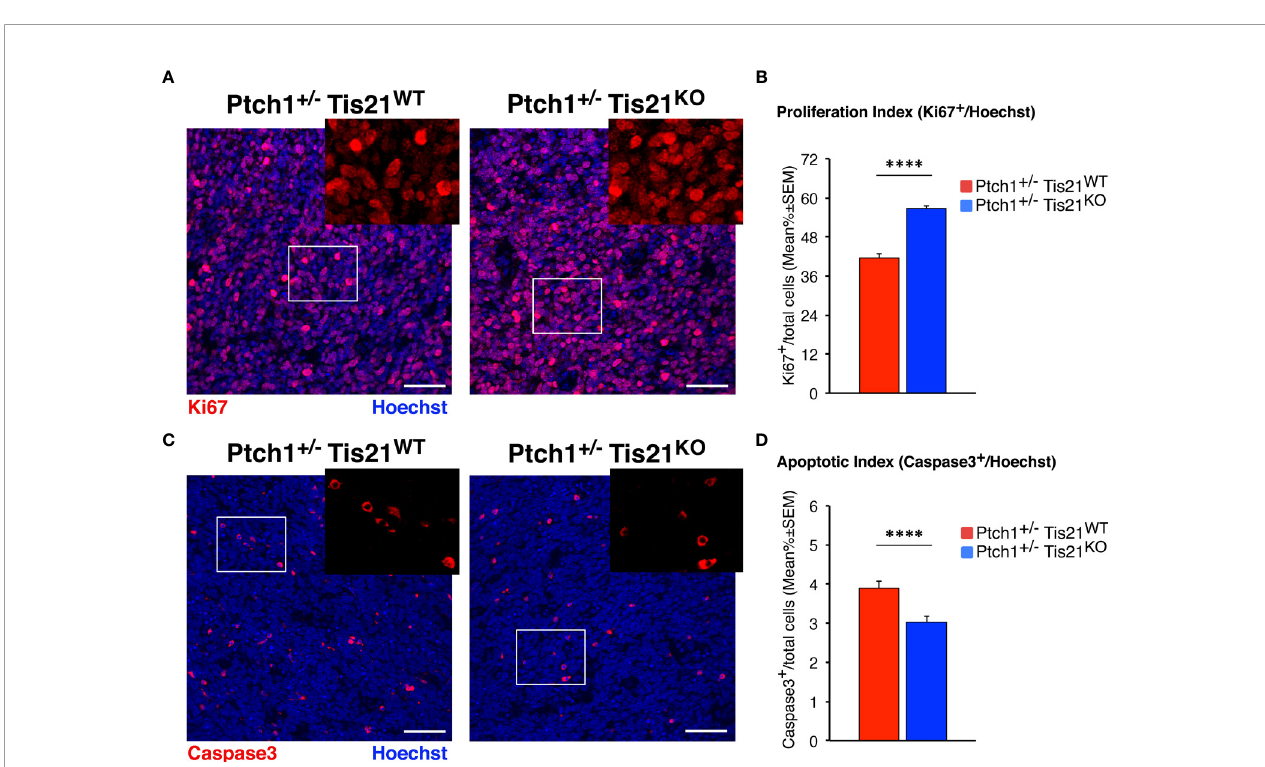
FIGURE 5 | In Ptch1 +/ − /Tis21 KO MBs, PI3K/AKT/mTOR activation is associated to increased proliferation and survival of tumor cells. (A) Representative confocal images of proliferating MB cells (labeled with the antibody against Ki67, in red) in tumors from Ptch1 +/ − /Tis21 WT and Ptch1 +/ − /Tis21 KO mice. Sections are counterstained with Hoechst 33258 to visualize the nuclei. Scale bar, 50 m m. The white box areas are shown with 2× digital magni fi cation. (B) Quanti fi cation of mean ± SEM percentage ratio of cells positive for Ki67 to the total number of cells (Hoechst-positive; proliferation index) in MBs from Ptch1 +/ − /Tis21 WT and Ptch1 +/ − /Tis21 KO mice. **** p < 0.0001, Mann-Whitney U -test. MBs analyzed: n = 4 for each genotype; total fi elds analyzed: n = 320. (C) Representative images by confocal microscopy showing the apoptotic MB cells, identi fi ed as activated Caspase-3 + cells (in red), in Ptch1 +/ − /Tis21 WT and Ptch1 +/ − /Tis21 KO tumors. Nuclei were stained with Hoechst 33258. Scale bars: 50 m m. Cells in boxed areas are shown at higher digital magni fi cation (2×). (D) Analysis in Ptch1 +/ − /Tis21 WT and Ptch1 +/ − /Tis21 KO MBs of the number of apoptotic cells, measured as mean ± SEM percentage ratio between number of activated Caspase-3 + cells and total number of cells (visualized by Hoechst 33258; apoptotic index). **** p < 0.0001, Mann-Whitney U -test. MBs analyzed: n = 4 for each genotype; total fi elds analyzed: n =